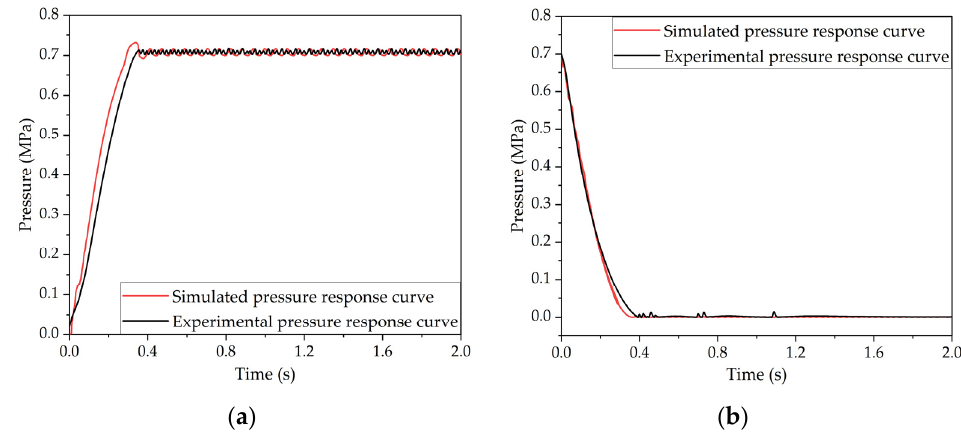
Figure 8. Verification of the co-simulation model for the LF-APRV and the dynamic PWM coupling pressure regulation method: ( a ) pressurization response curves and ( b ) decompression response curves.